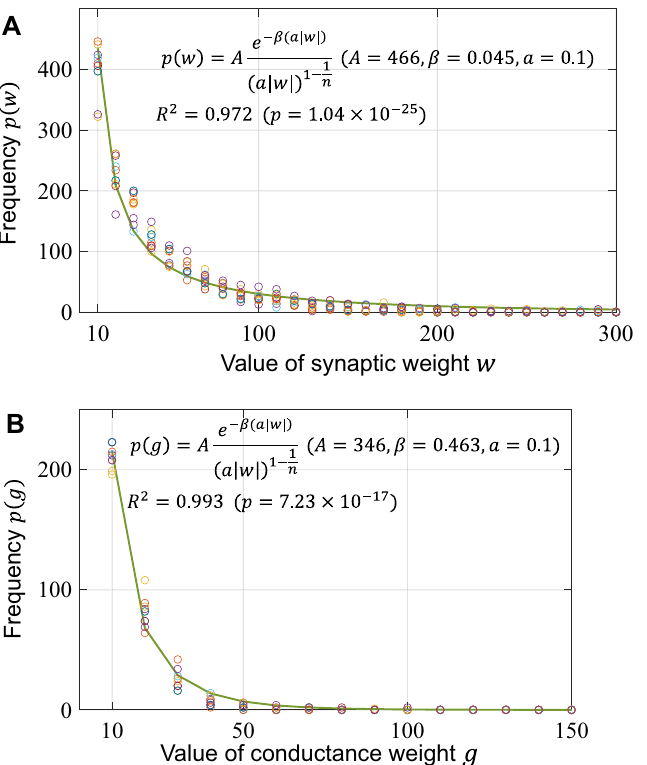
Figure 9. Distribution of weight parameters. ( A ) Frequencies in the corresponding bins as a function of the synaptic weights. ( B ) Frequencies as a function of the conductance weights. The solid green lines represent the fit to the modified Boltzmann distribution. The distributions were obtained from 10 training trials with different initial values. The colors of the circles in the plots distinguish the different training